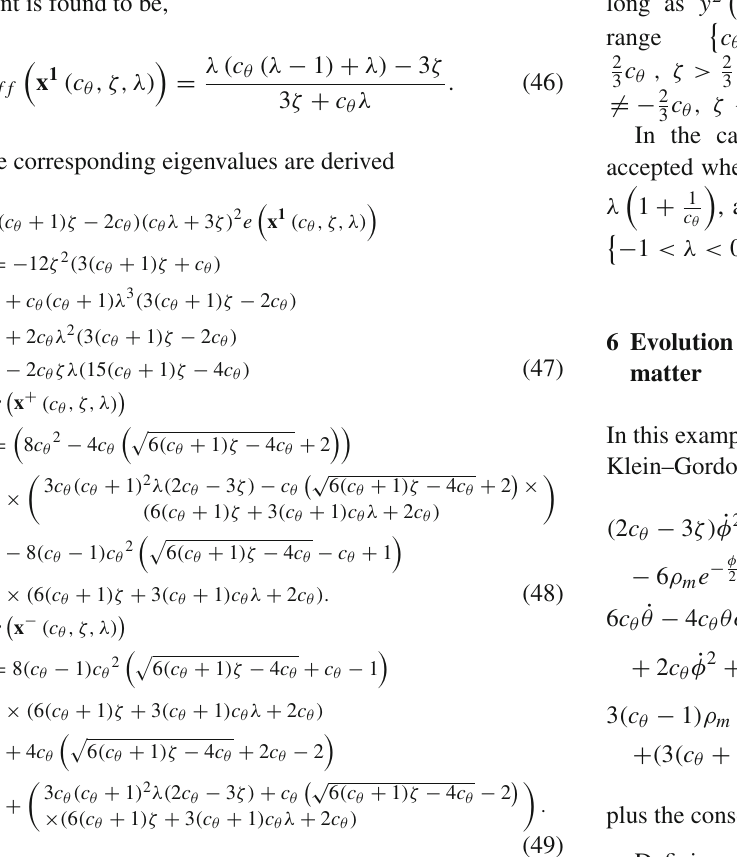
a universe where the scalar field potential also contributes to the effective cosmological fluid, while the equation of state parameter w ef